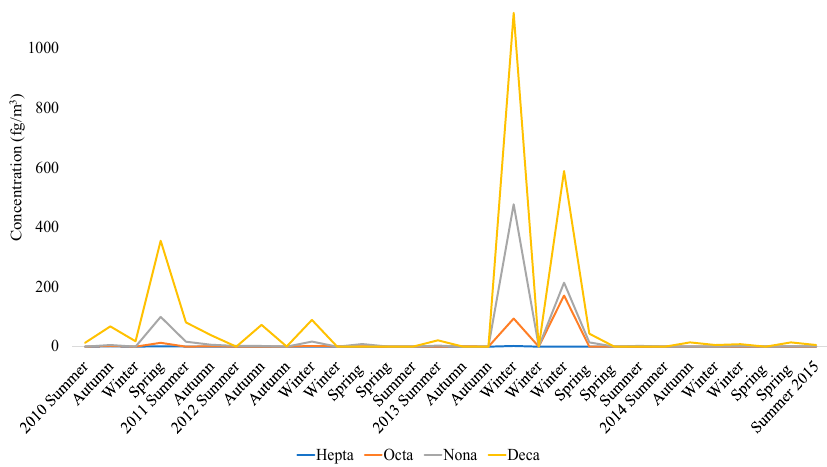
Figure 4. Levels of higher brominated PBDEs according season and